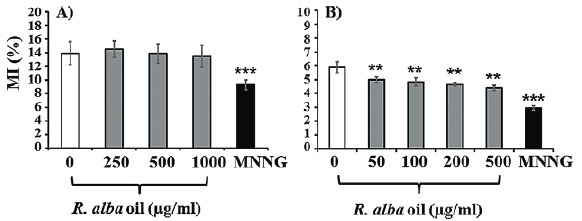
Figure 4. Value of mitotic activity (MI) observed after Rosa alba L. essential oil treatment in Hordeum vulgare (A) and in human lym- phocyte cultures (B). Mitotic activity is calculated as a percent of the control. Data are expressed as mean ± SD of three independ- ent experiments. **p<0.01; ***p<0.001 compared with the negative control.